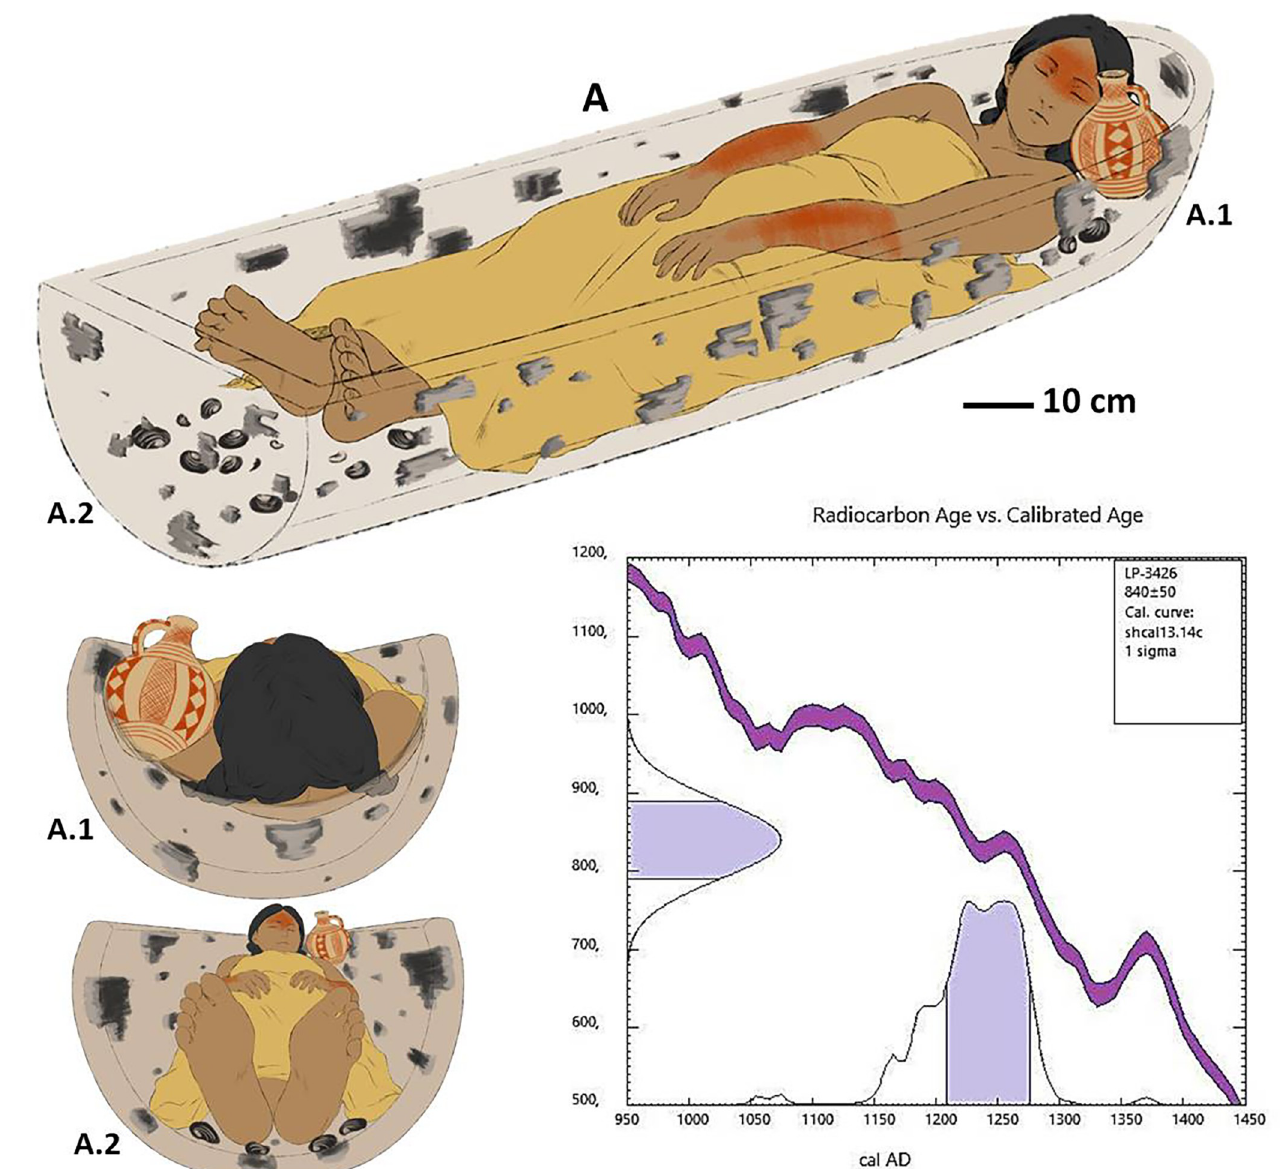
Fig 6. Reconstruction of the position of the body, associated artefacts and 14 C dating of the body (S5 Fig).